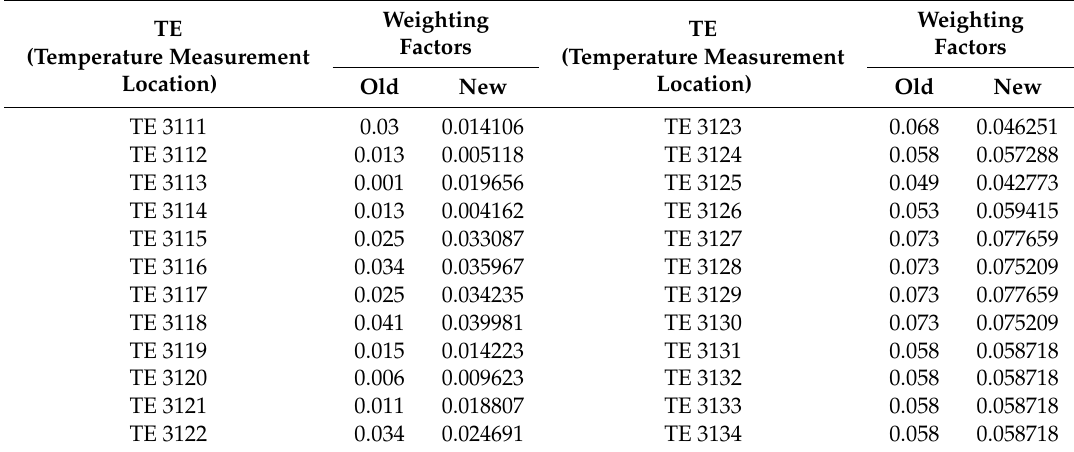
Table 1. Volume weighting factors for temperature measurements.